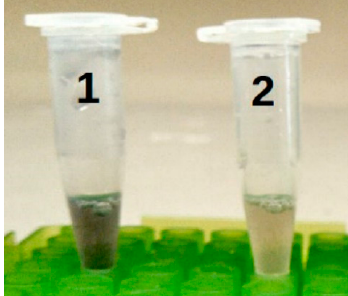
Figure 4. Magnetic bead ELISA. All tubes contained the beads, biotinylated probe of IS 711 gene, and digoxigenin-labelled probe to a distinct IS 711 DNA region. Tube 1 contained the PCR amplicon from a lysate of 7 × 10 6 cells of Brucella abortus . Tube 2 contained all the reaction components of tube 1, but the genomic DNA was not amplified by PCR.